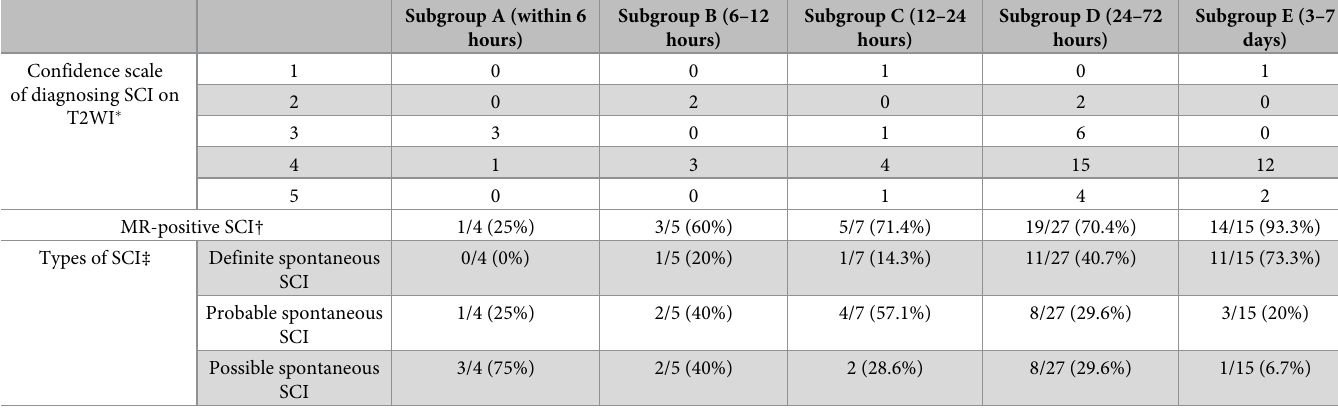
Table 3. The confidence scores for diagnosing spinal cord infarction on T2WI, the rate of T2WI-positive spinal cord infarction, and the types of SCI in each subgroup. Subgroup A (within 6